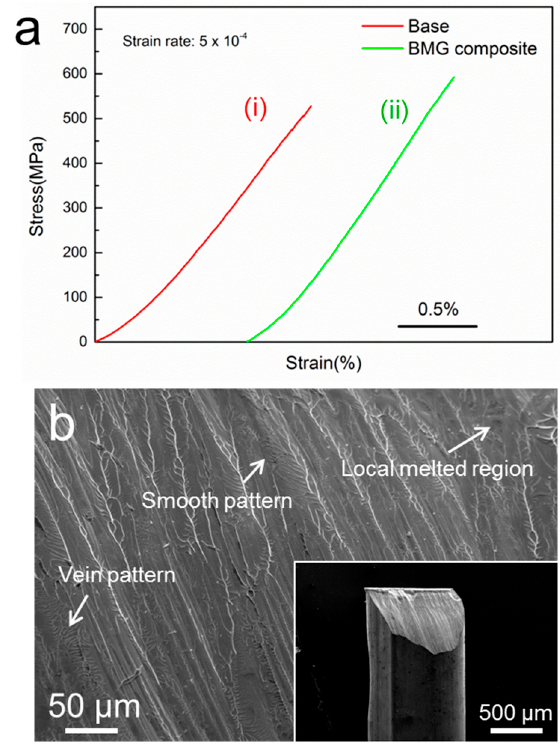
Figure 3. ( a ) Compressive stress-strain curves for ( i ) base and ( ii ) BMG composite; and ( b ) SEM images of fracture surfaces for the composite (image at low magnification is